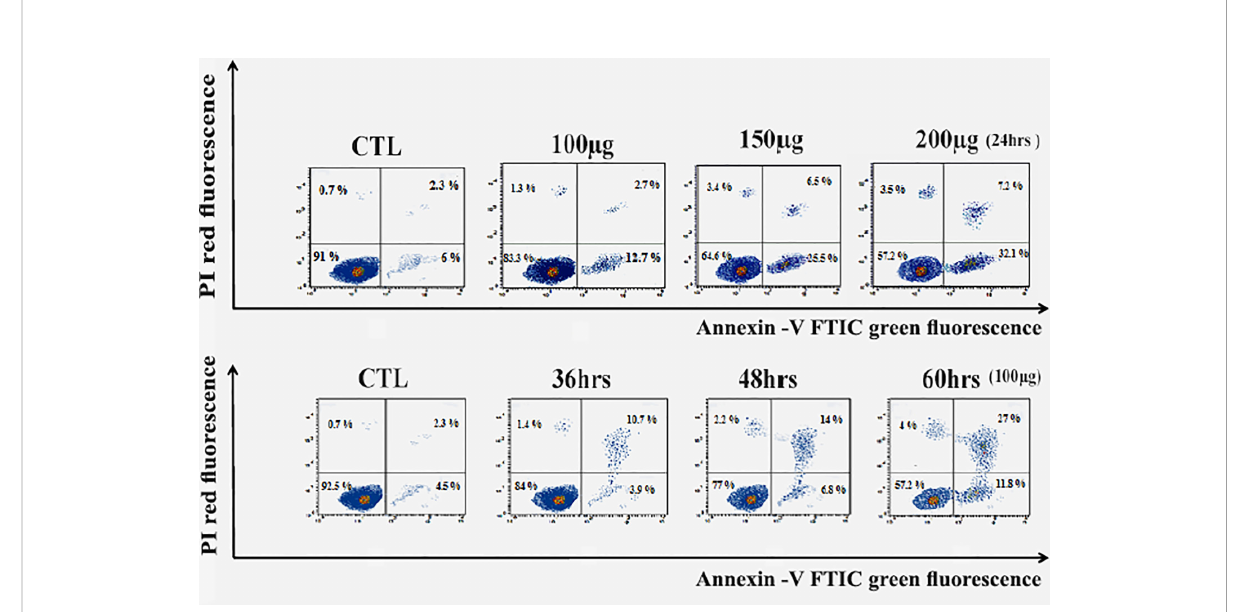
FIGURE 5 Apoptosis Assay with Annexin V-FITC/PI staining of HuH7 cell line. LL, Viable cells (Annexin V − /PI − ), LR, early apoptotic cells (Annexin V +/PI − ), UL, late necrotic cells (Annexin V − /PI +) and UR, late apoptotic/necrotic cells (Annexin V +/PI +).